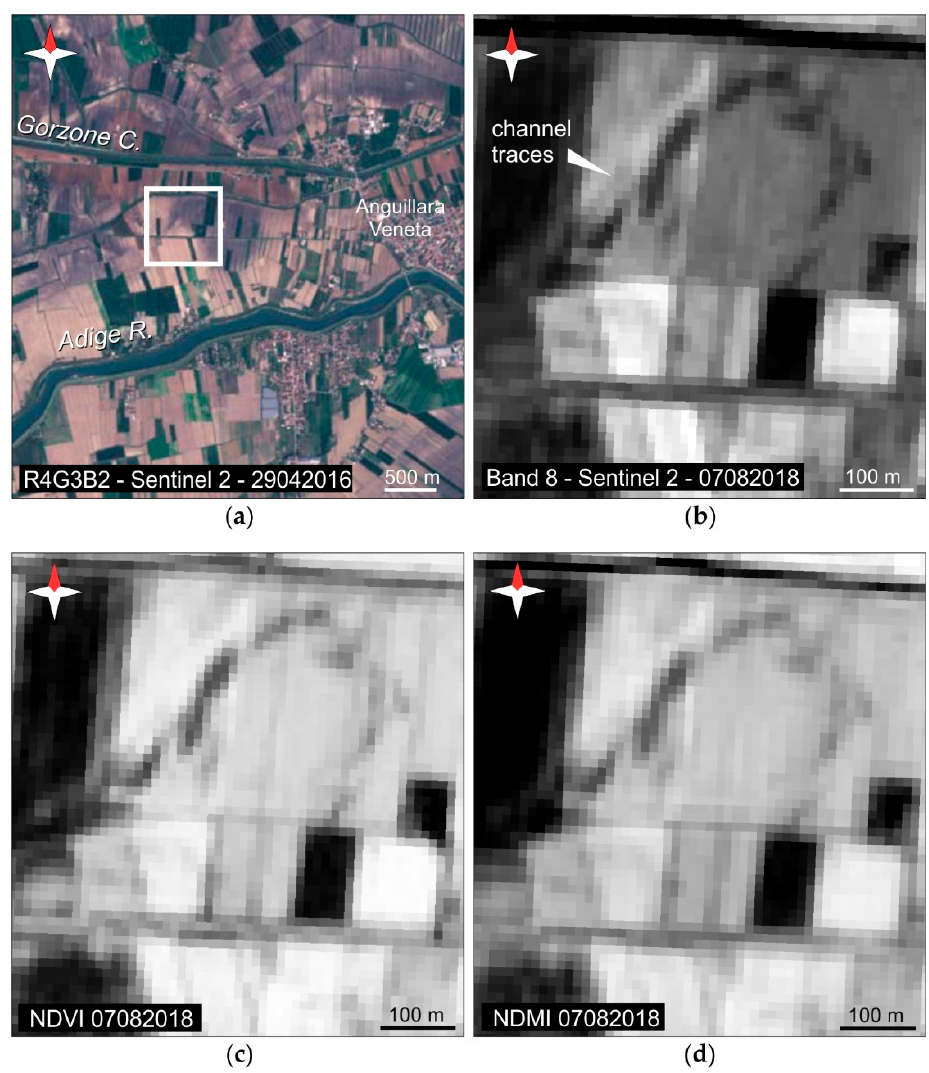
Figure 4. Remote-sensing results: ( a ) aerial photogram of the study area enhancing the poorly visible fluvial pattern during winter time; ( b ) meander belt reconstruction and fluvial morphology identification in the study area—white dashed lines highlight evidence of scroll-bar morphologies; and ( c – f ) satellite images (2016, 2013, 2012) providing information about fluvial morphology on the basis of Remote Sens. 2020 , 12 , x FOR PEER REVIEW seasons and soil use.